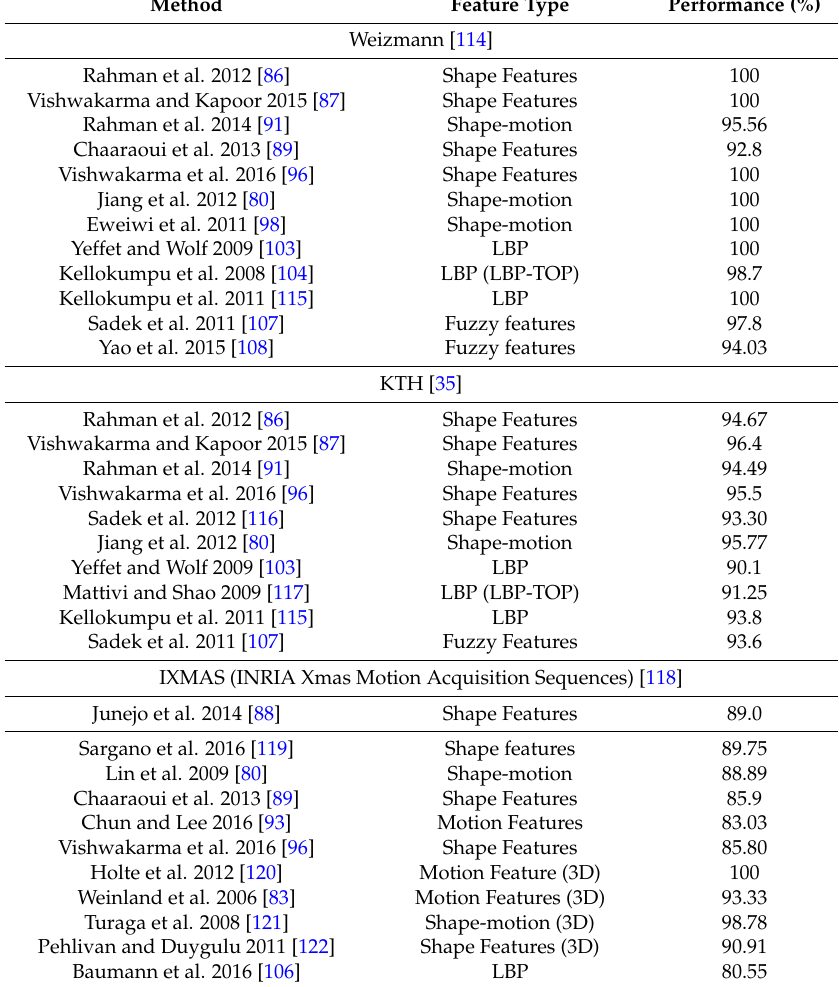
Table 2. Comparison of appearance, LBP (Local Binary Pattern), and fuzzy logic-based